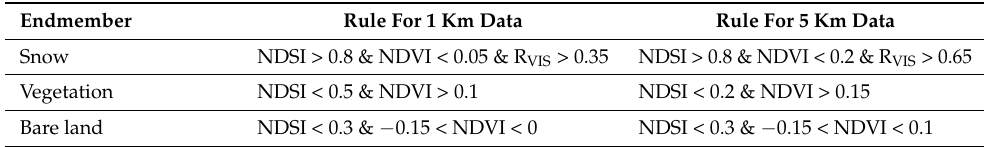
Table 4. AVHRR/2 MESMA algorithm endmember extraction